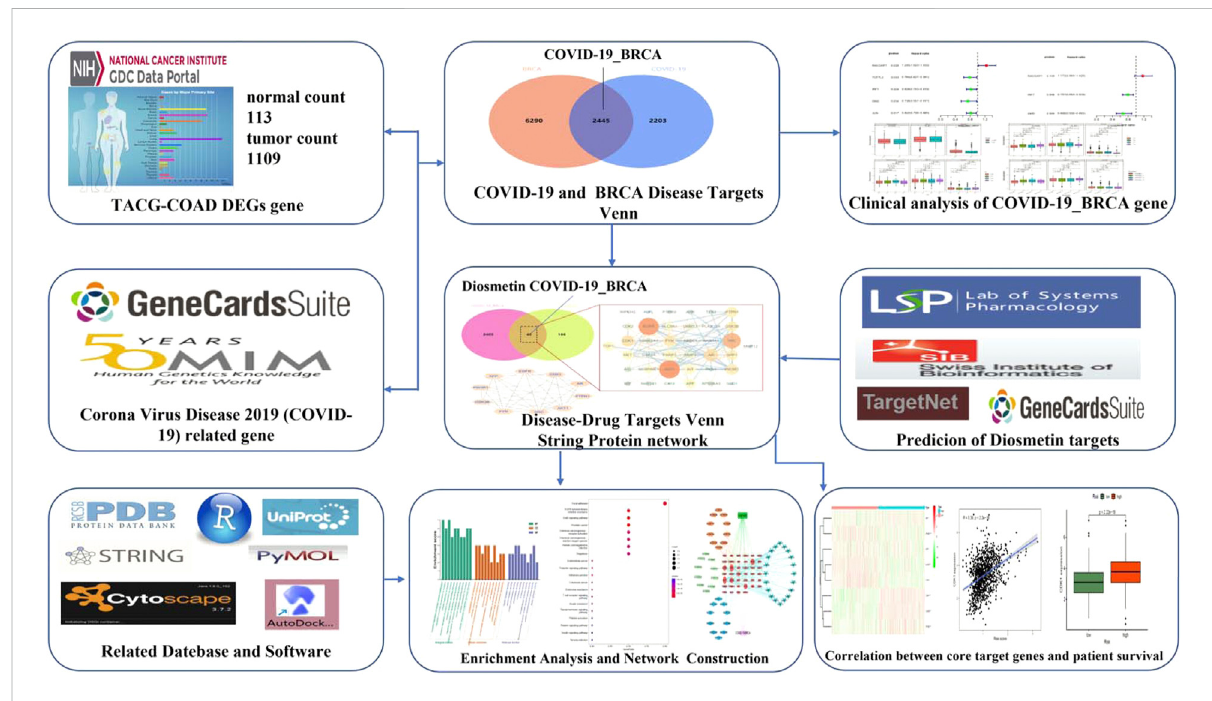
FIGURE 1 Study work fl ow. Computational bioinformatics analysis technique; the fi gure depicts the action and mechanism of Diosmetin against BRCA/